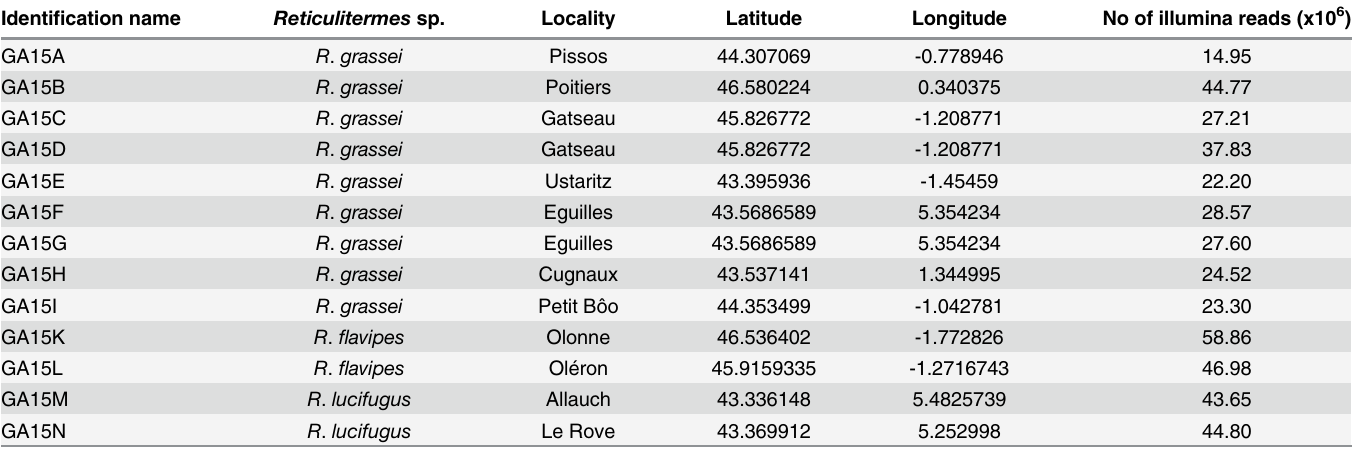
Table 1. Information and sequencing results of nymphoid neotenic female termites used in this study. Identi fi cation